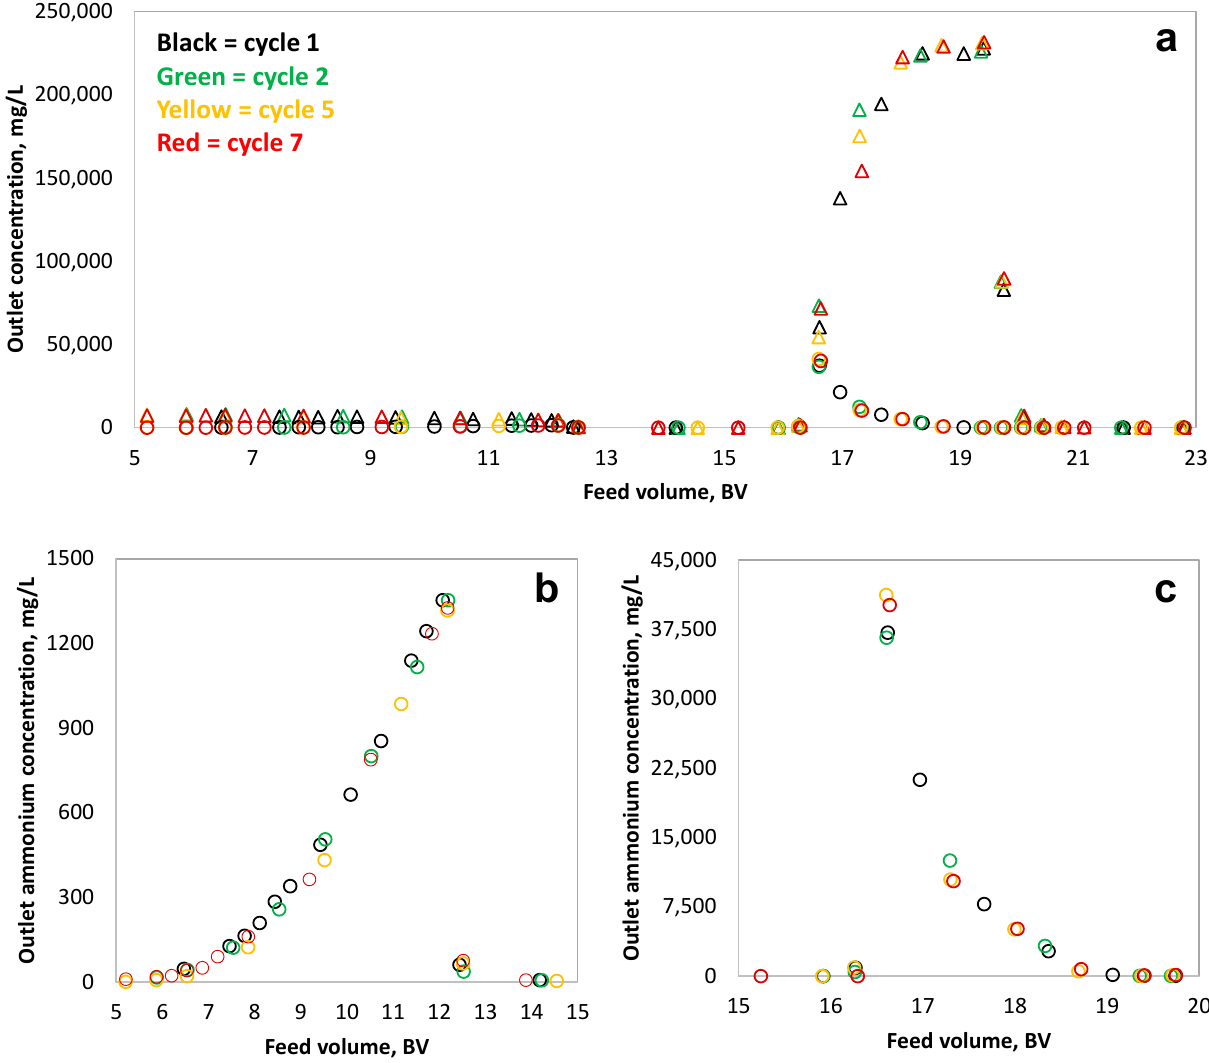
Figure 3. ( a ) Cyclic separation profiles of cycles 1, 2, 5, and 7 in laboratory-scale stability tests, ( b ) the ammonium profiles of loading, ( c ) the ammonium profiles of regeneration (CS16GC in K + form, V bed = 35.34 mL, Q = 4 BV/h at 60 °C, loading: 12 BV 0.179 mol/L NH 4 Ac, washing: 4 BV water, regeneration: 3 BV 2 mol/L K 3 PO 4 , second washing: 4 BV water). Triangles: K + ; circles: NH 4+ .